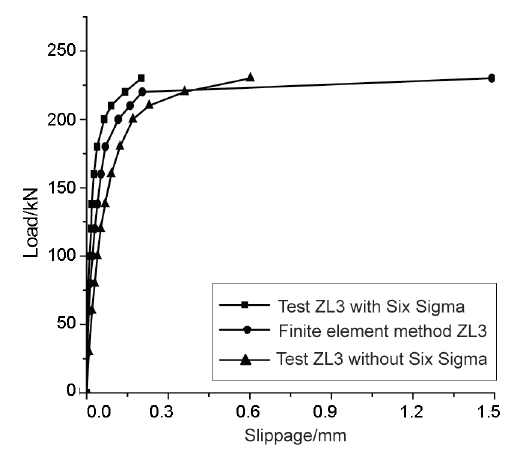
Fig. 9. Load-slip curves